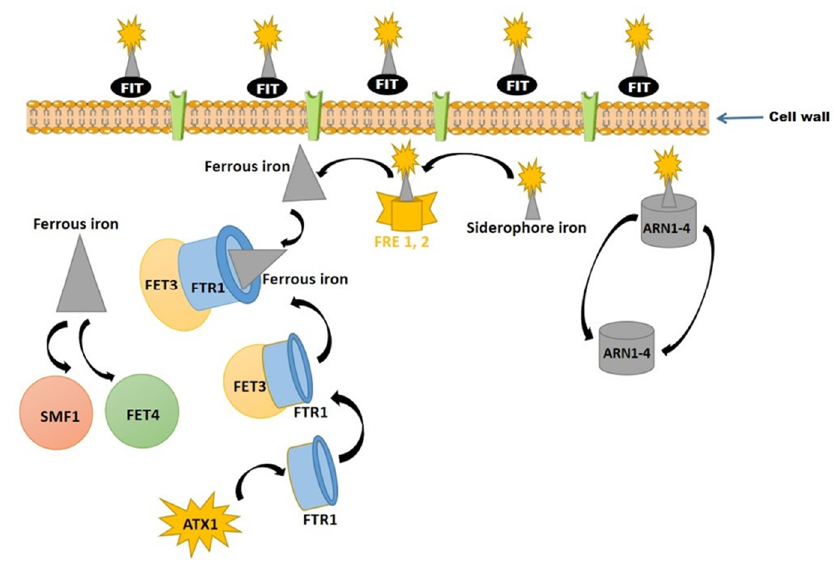
Figure 5. Mechanisms of ferric ion (Fe III) transport in the yeast cell, and subsequent transformation into ferrous ion (Fe II).